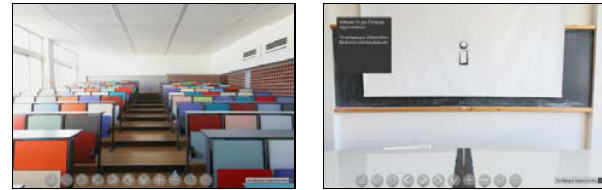
Figure 18. Anaglyph students’ project at the School of Architecture